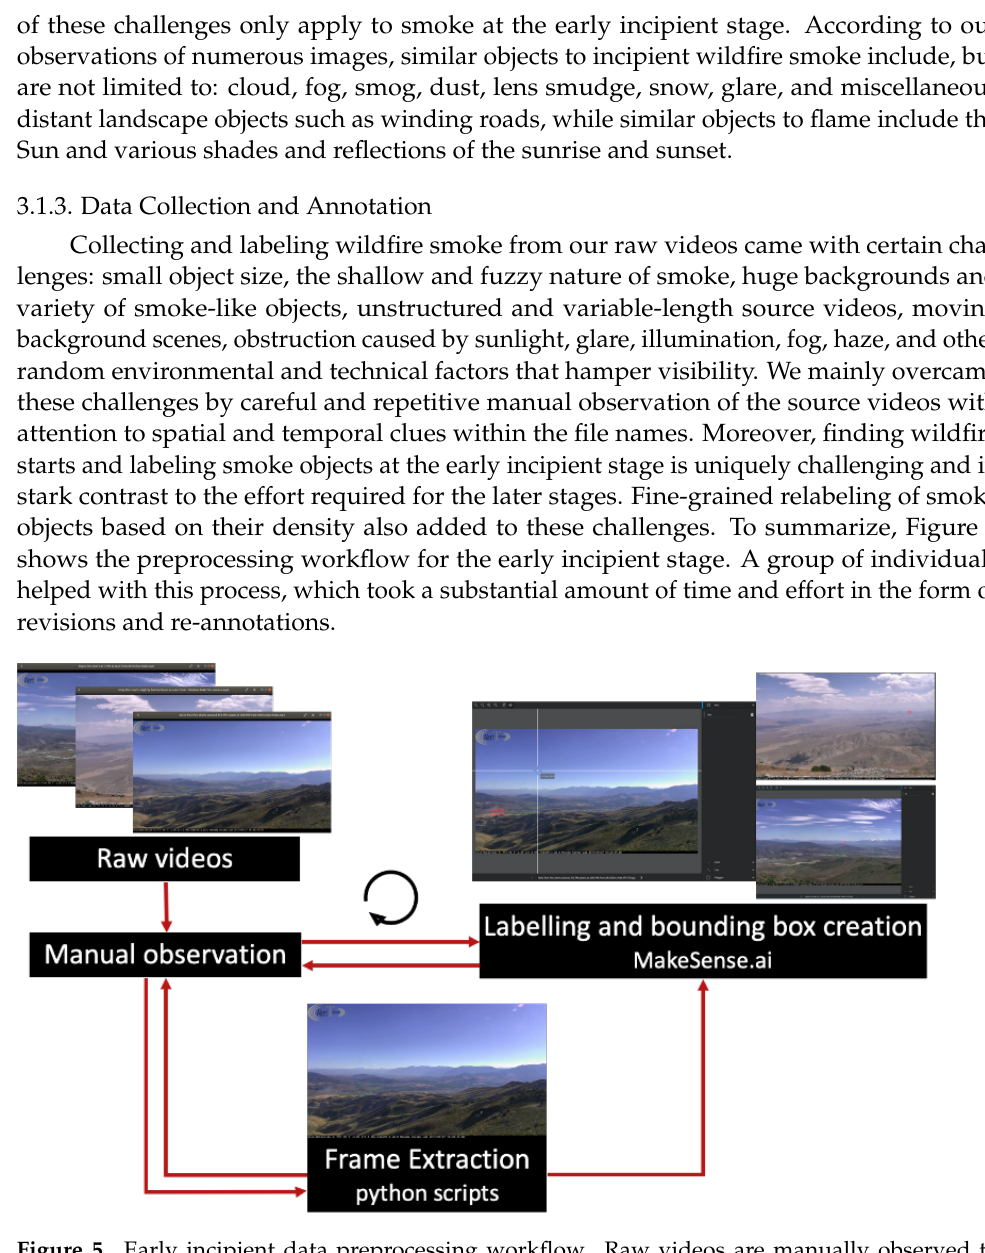
Figure 5. Early incipient data preprocessing workflow. Raw videos are manually observed to determine the appropriate period for data extraction, using automated scripts. This is particularly necessary for long videos. The extracted images are then labeled with bounding boxes using the makesense.ai tool [95]. Since smoke at this stage tends to be small and typically not or hardly visible, a continuous feedback loop is crucial to locate smoke and draw the bounding boxes correctly. Finding wildfire starts is particularly difficult, since they are shallow and typically on or near the